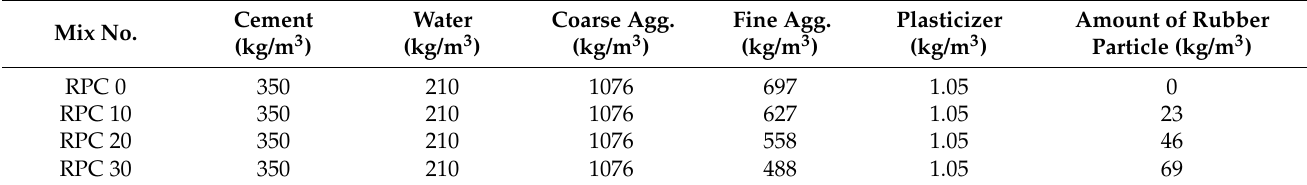
Table 1. Used mix proportions.